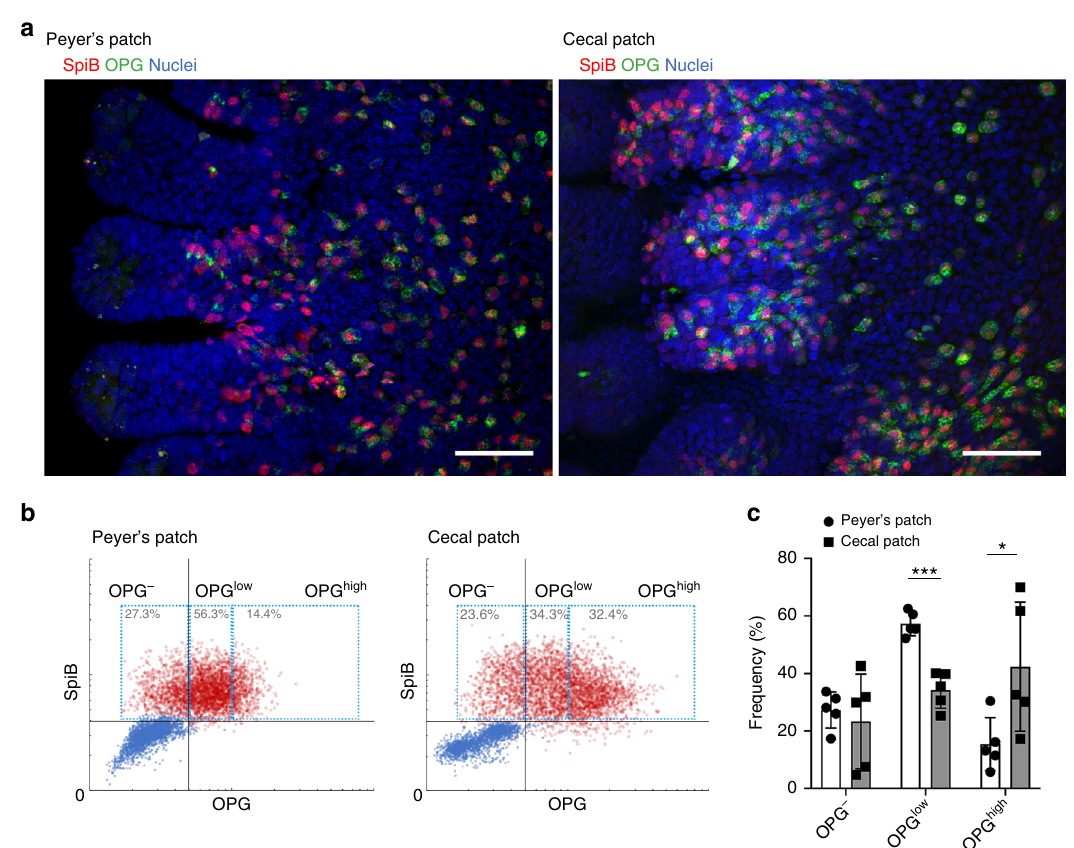
Fig. 3 OPG high M cells cluster more in cecal patches than in Peyer ’ s patches. a Whole-mount immunostaining of the FAE of Peyer ’ s patches (left) and cecal patches (right) for OPG (green) and Spi-B (red). Nuclei were stained with DAPI (blue); scale bars: 50 µ m. b Scatter plots of the fl uorescence intensities of OPG versus Spi-B. Red dots represent cells stained with anti-Spi-B antibody that was conjugated with HyLyte Fluor 555 and anti-OPG antibody that was conjugated with HyLyte Fluor 647. Blue dots represent background fl uorescence intensity of randomly selected non-stained cells. Fluorescence intensities were measured for at least 3000 cells from fi ve FAEs of three mice. c Frequencies of OPG high M cells in Peyer ’ s patches and cecal patches were quanti fi ed. * p < 0.05, *** p < 0.005. Student ’ s t -test, n = 5 FAE from three animals. The source data underlying panels b and c are provided as a Source Data fi